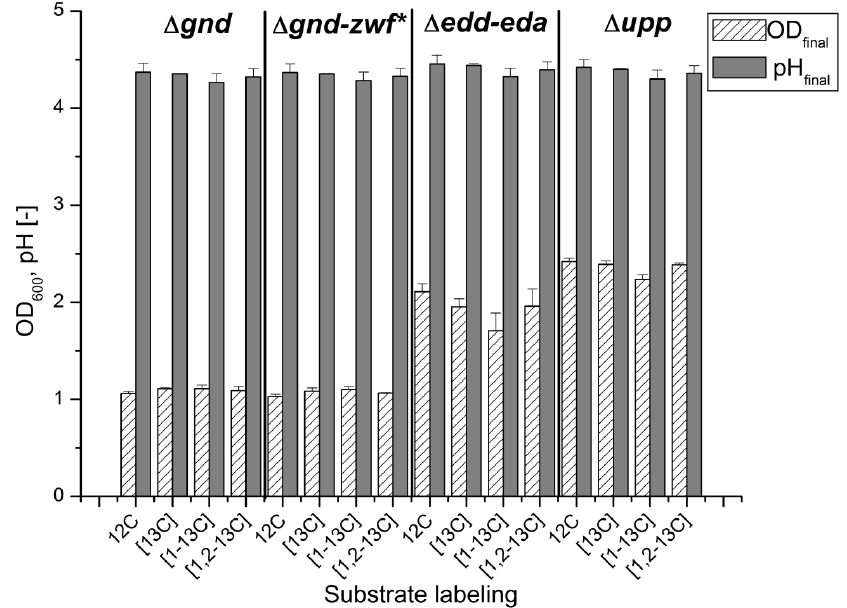
Figure 1. Offline measurement of final OD (white, dashed) and final pH value (grey) after 24 h of cultivation for all combinations of mutant strain and 13 C-labeled